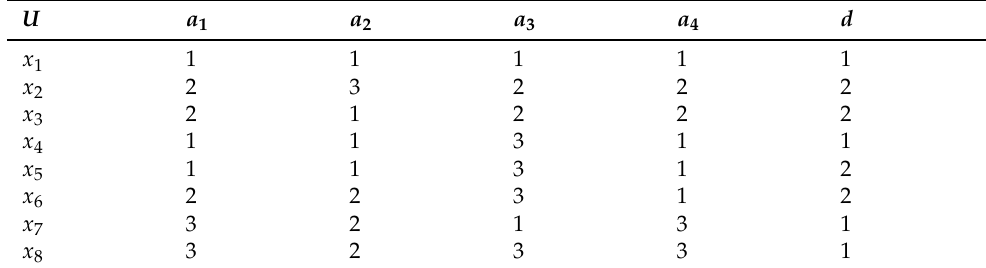
Table 1. A description of information